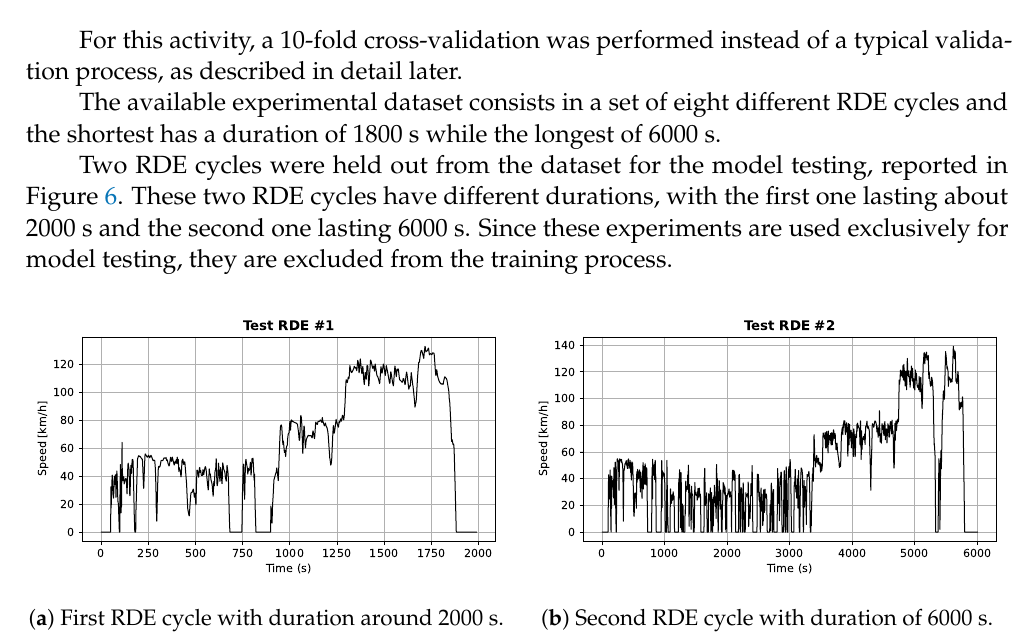
Figure 6. Speed profile of two Real Driving Emission cycles within the test set.